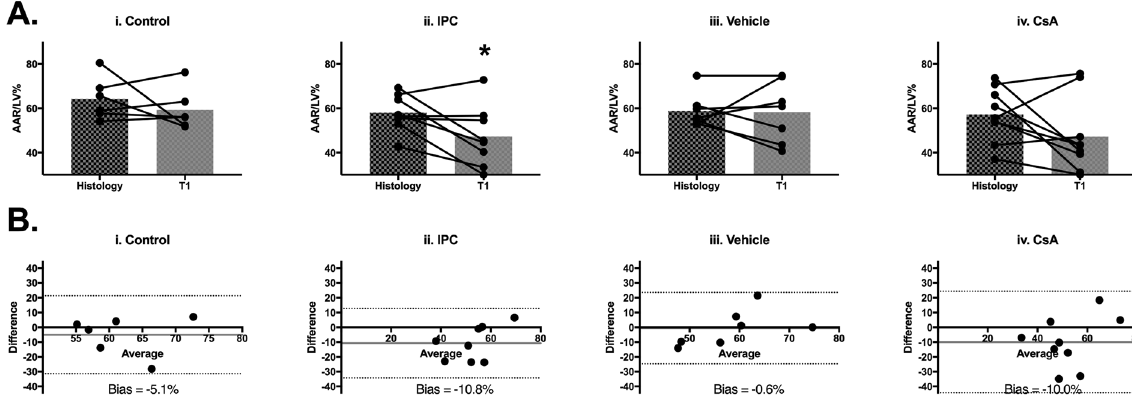
Figure 8. T 1 mapping for in vivo AAR to determine influence on the ASL signal. ( A ) Quantification of AAR as a fraction of left ventricle area (AAR/LV%) by histological staining and T 1 -mapping in animals in control group (n = 6) (i), IPC group (n = 10) (ii), vehicle group (n = 8) (iii) and CsA group (n = 9) (iv). Mean ± standard deviation values are provided in Supp. Table 2. Significant underestimation of AAR/LV% is observed for the IPC group ( * p = 0.04). ( B) Bland-Altman plots comparing histological and T 1 -mapping methods of estimating AAR/LV% for all groups